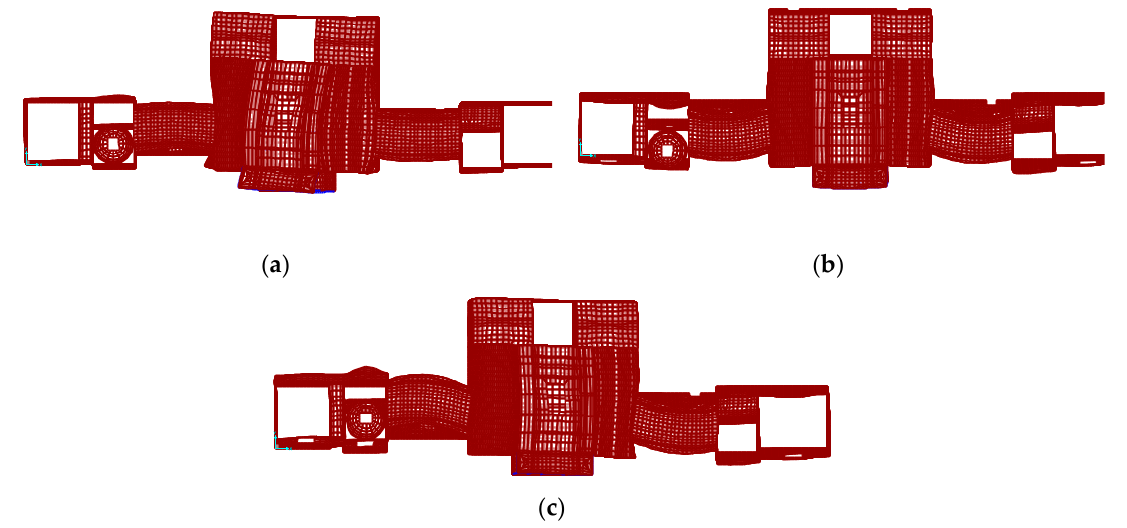
Figure 5. Mode shapes of the case study: ( a ) Mode 1; ( b ) Mode 2; ( c ) Mode 3.